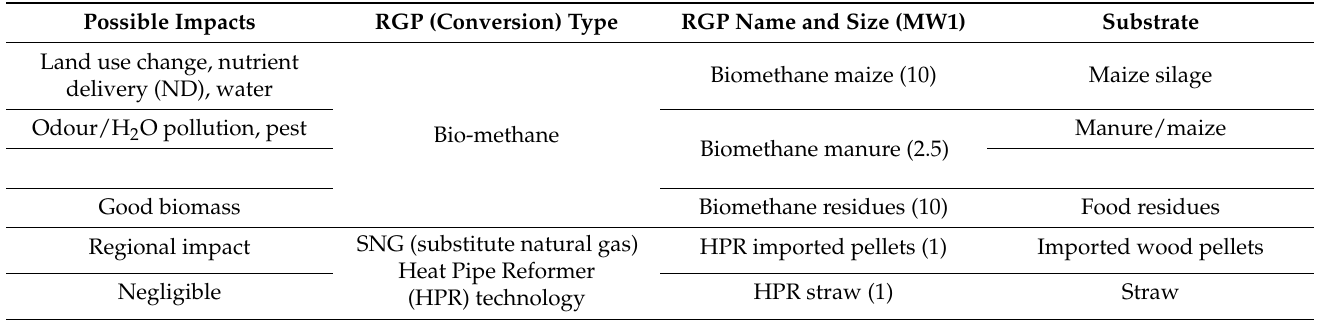
Table 1. Renewable Gas Plant (RGPs) combination with their feedstock’s impact and plant size. Possible